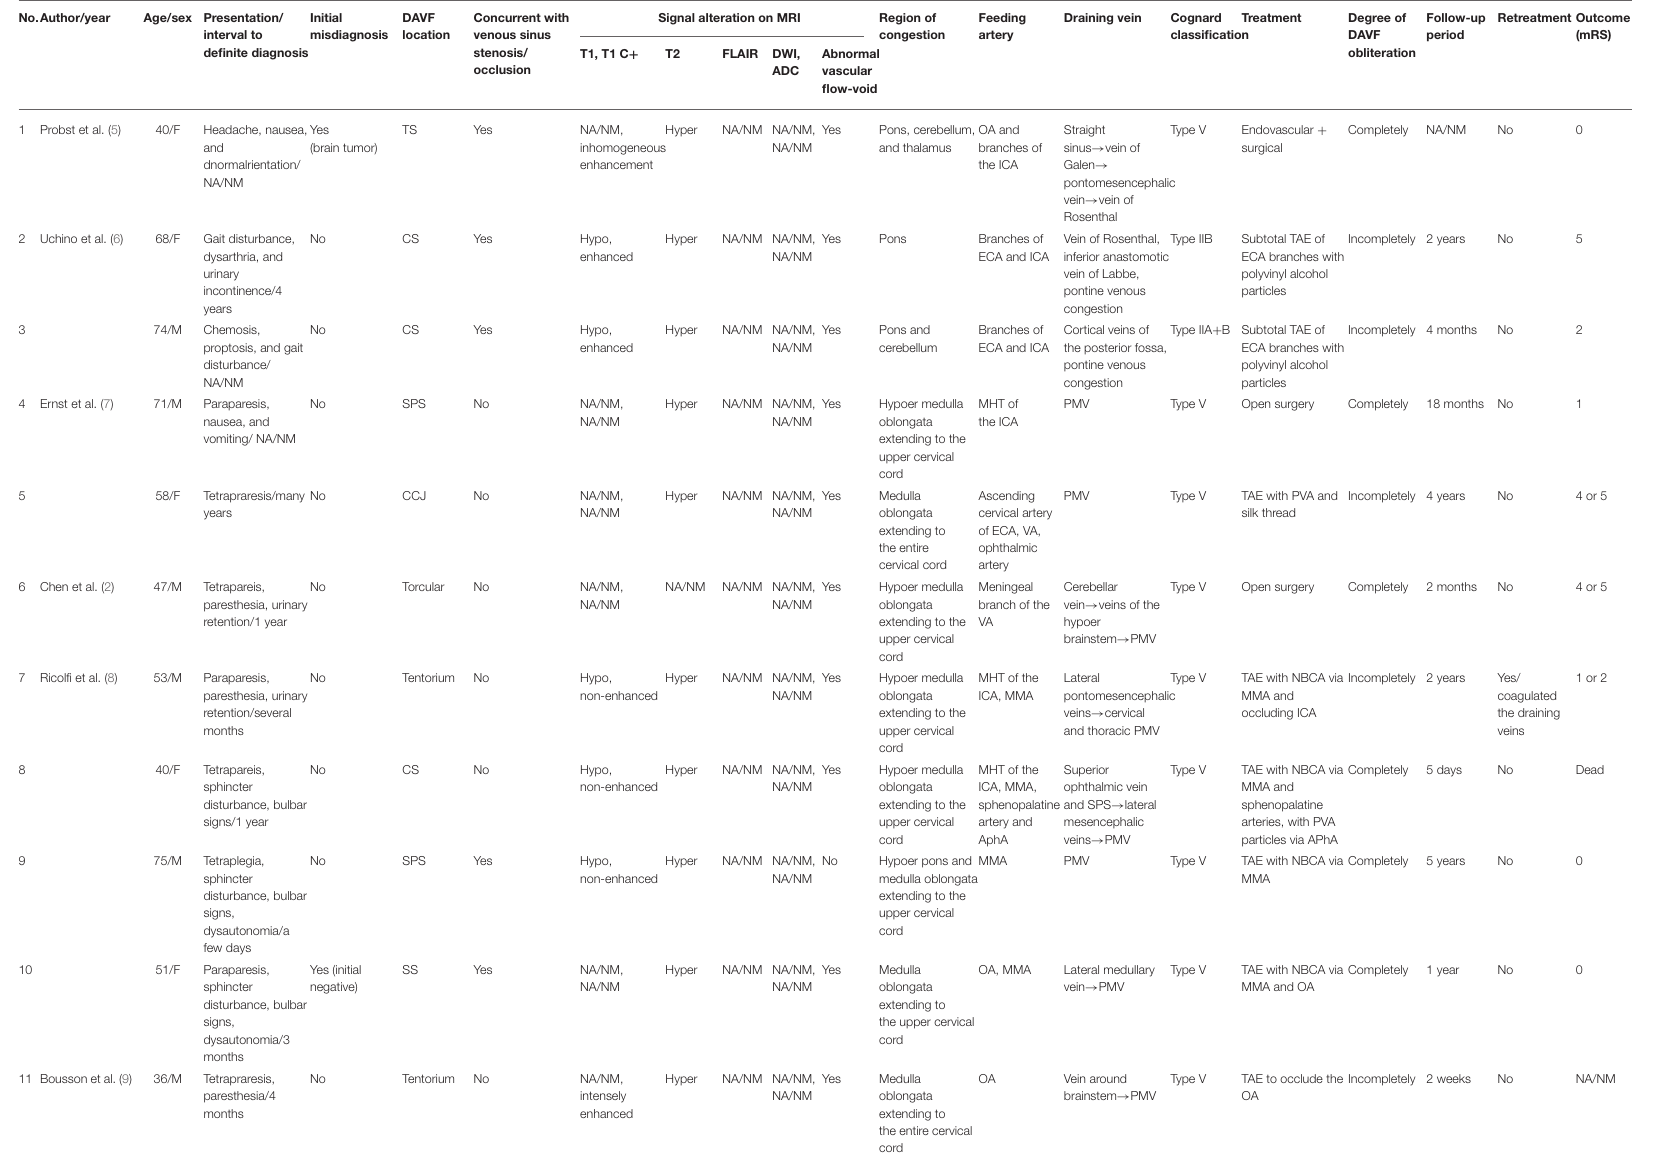
TABLE 1 | Intracranial DAVFs complicated with brainstem